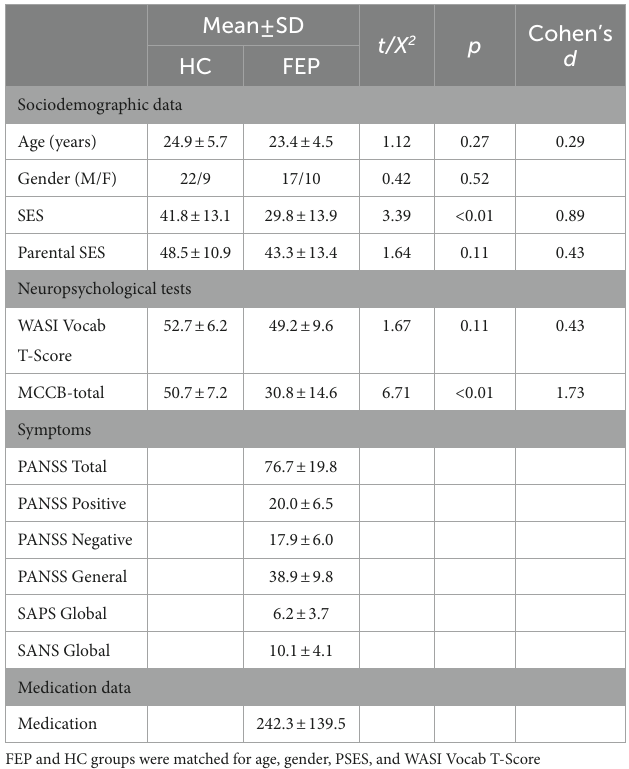
TABLE 1 Demographic, neuropsychological, and clinical information (previously reported in Curtis et al.,